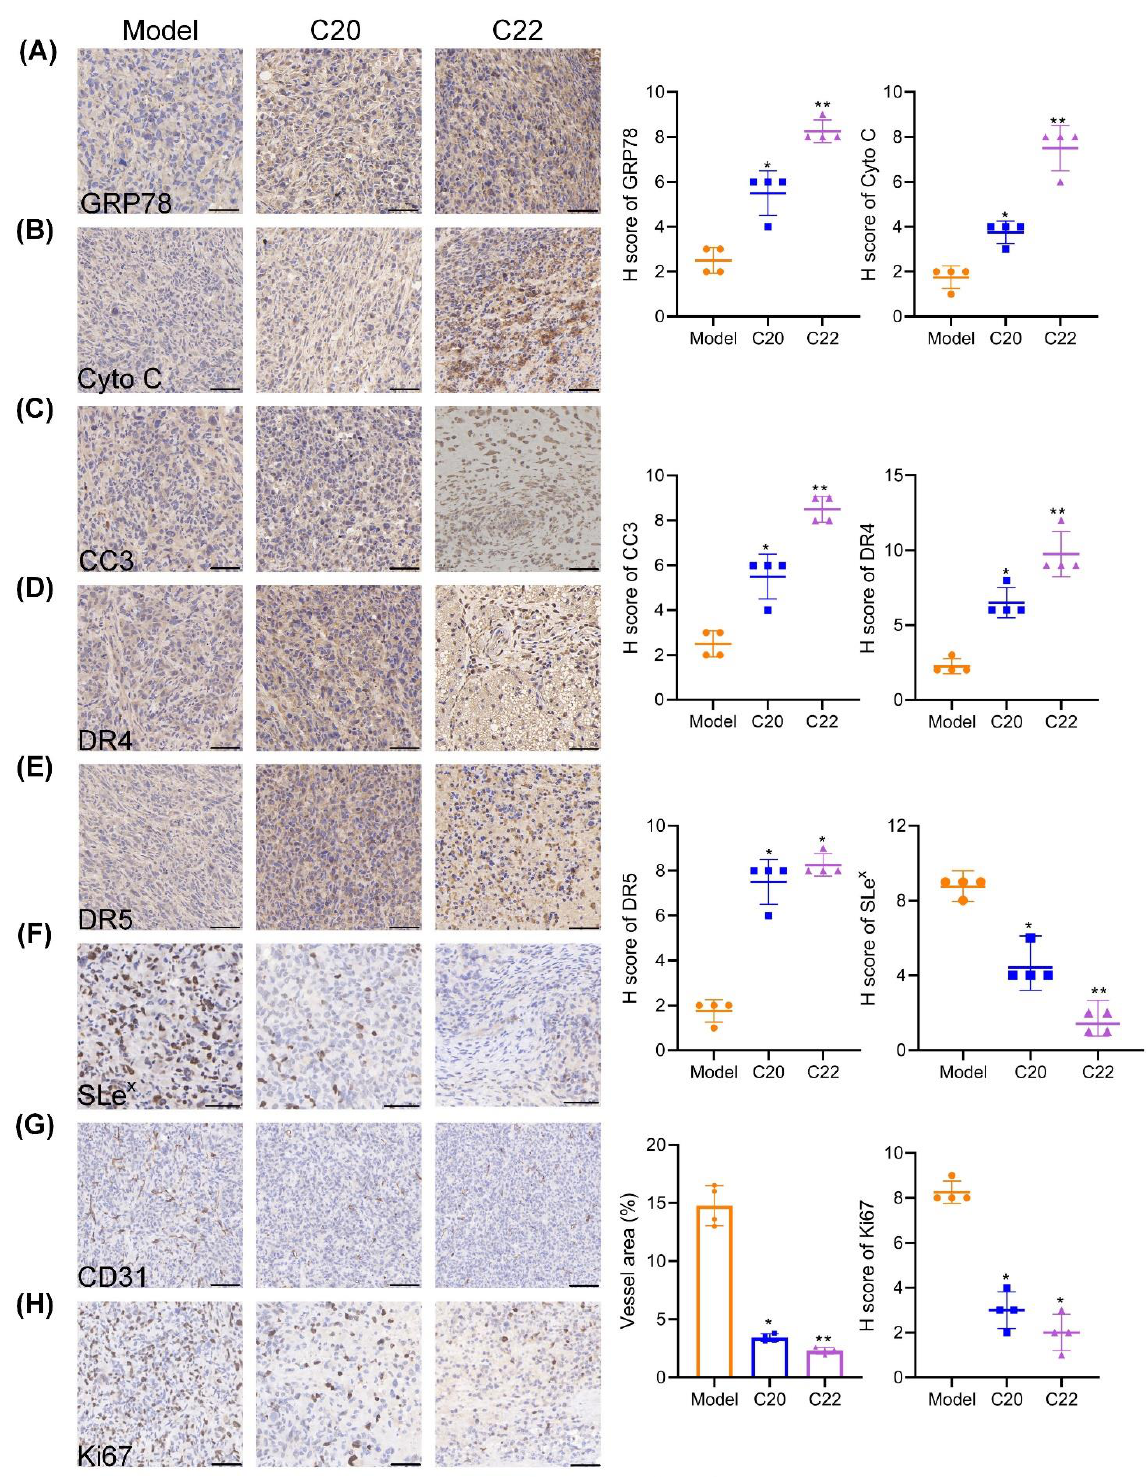
Figure 10. Immunohistochemical analysis of tumor sections from model group and the groups administrated with C20/C22. ( A ) GRP78 staining tumor sections ( n = 4). ( B ) Cyto C staining tumor sections ( n = 4). ( C ) CC3 staining tumor sections ( n = 4). ( D , E ) Death receptors DR4 and DR5 staining tumor sections ( n = 4). ( F ) SLe x staining tumor sections ( n = 4). ( G ) CD31 staining tumor sections ( n = 4). ( H ) Ki67 staining tumor sections ( n = 4). Scale bars, 50 μm. Data are presented as the mean ± SD. The p -value was analyzed by nonparametric Dunnett’s test using GraphPad Prism version 8.00. * p < 0.05, ** p < 0.01 treatment groups vs. model